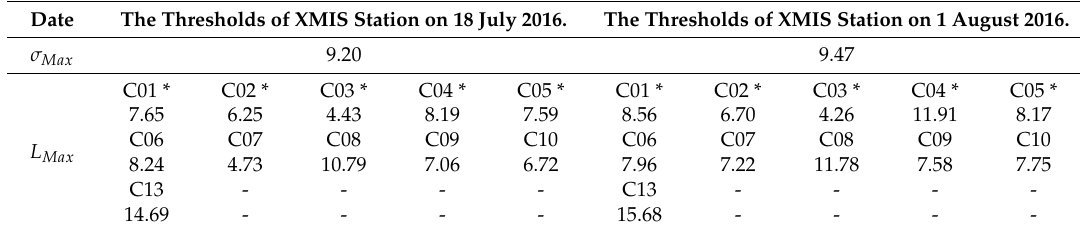
Table 1. The thresholds of the orbital maneuver detection (unit: meter).